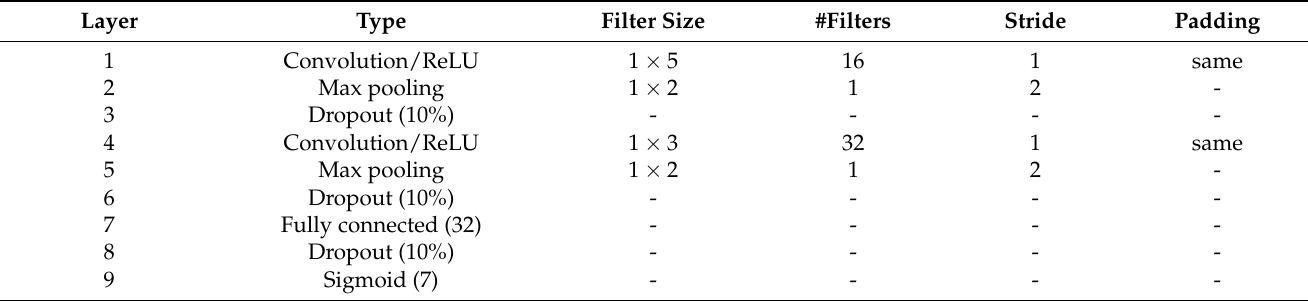
Table 1. Convolutional neural network architecture for experiment 1.